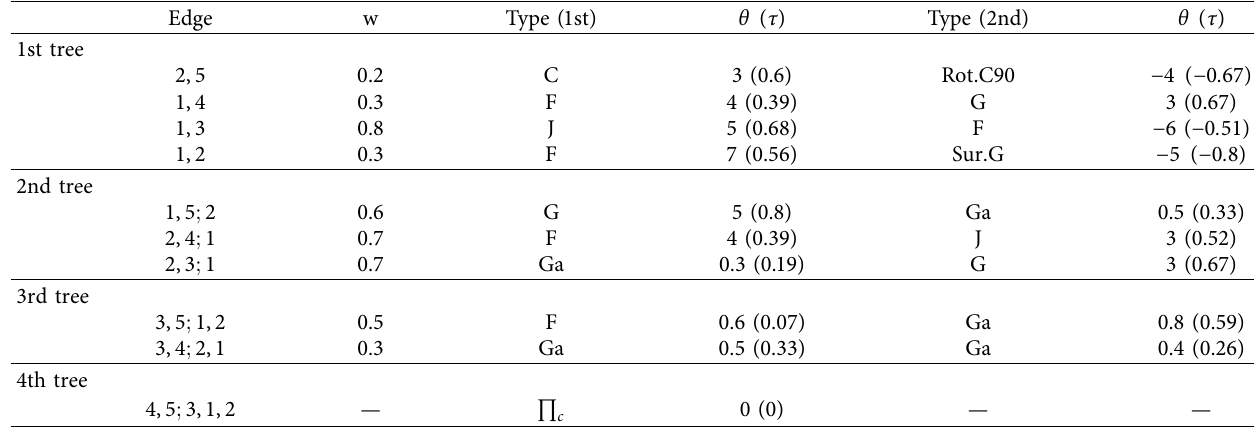
Table 2: Summary of 3-levels truncated R -vine copula mixture models.